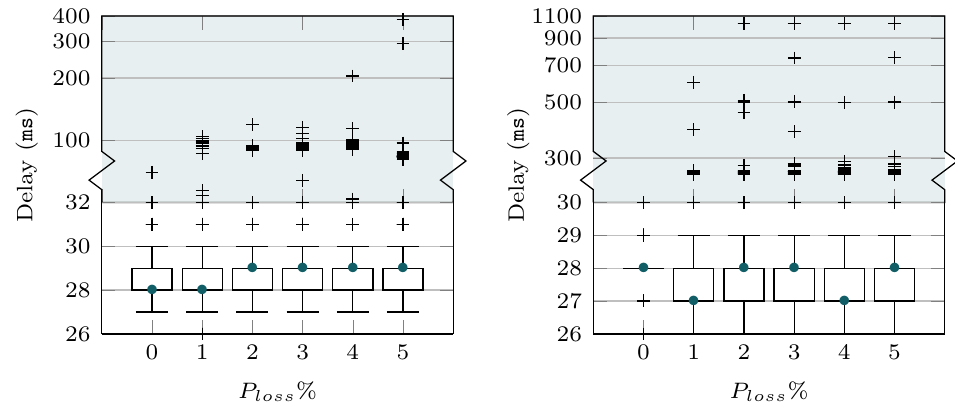
Figure 5. Boxplot of the delay experienced with QUIC and TCP over the WiFi channel. Ordinate axis is split to show the range of outliers, which are shown using a logarithmic scale. ( a ) QUIC ( b ) TCP.